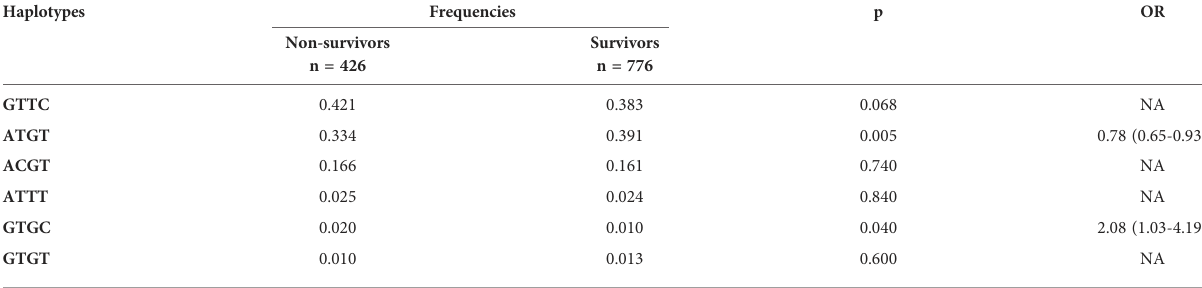
TABLE 4 Association analysis of IFNAR2 haplotypes (rs3153/rs2229207/rs1051393/rs2834158) with mortality risk among patients with severe COVID-19. Haplotypes